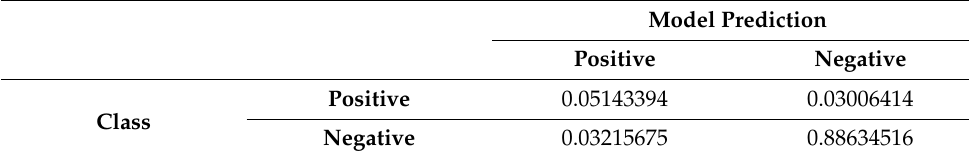
Table 6. Confusion matrix (Improved U-Net #2/ small number of particles).